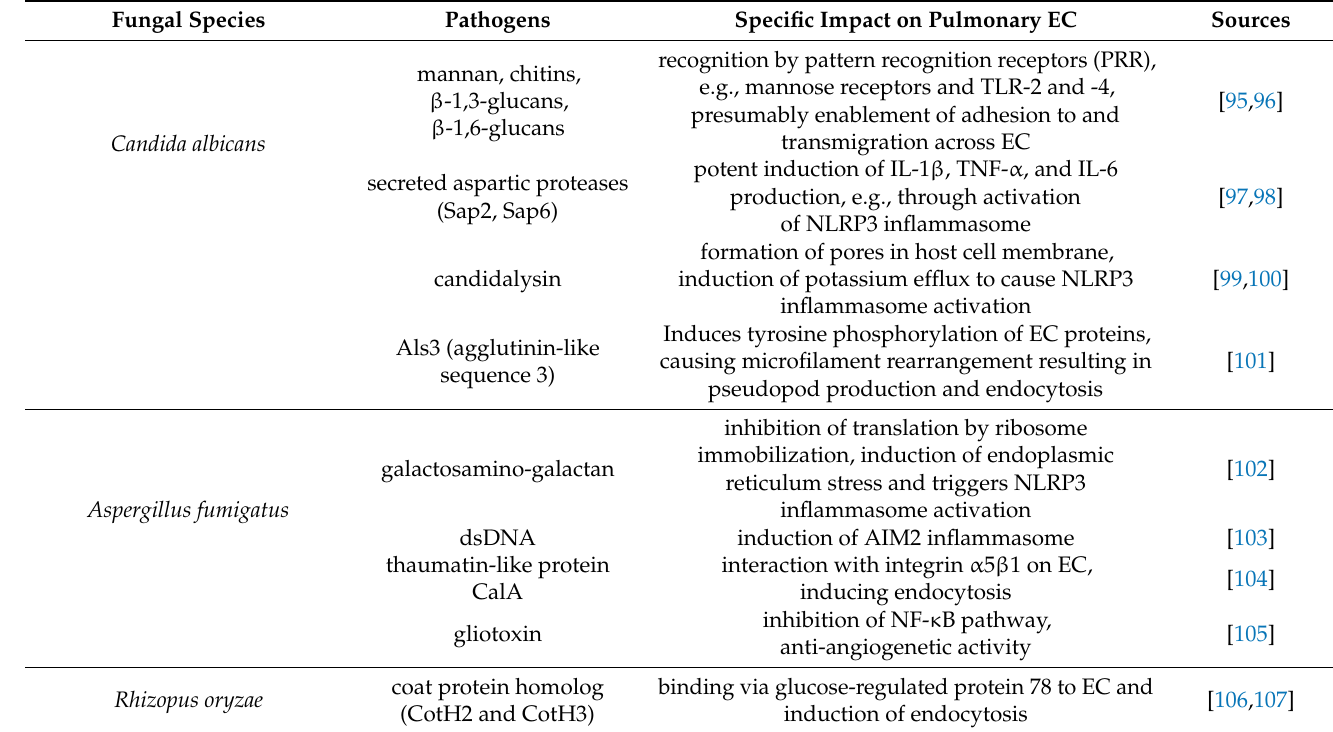
Table 3. Effects of several fungal pathogens on lung endothelial cells in invasive